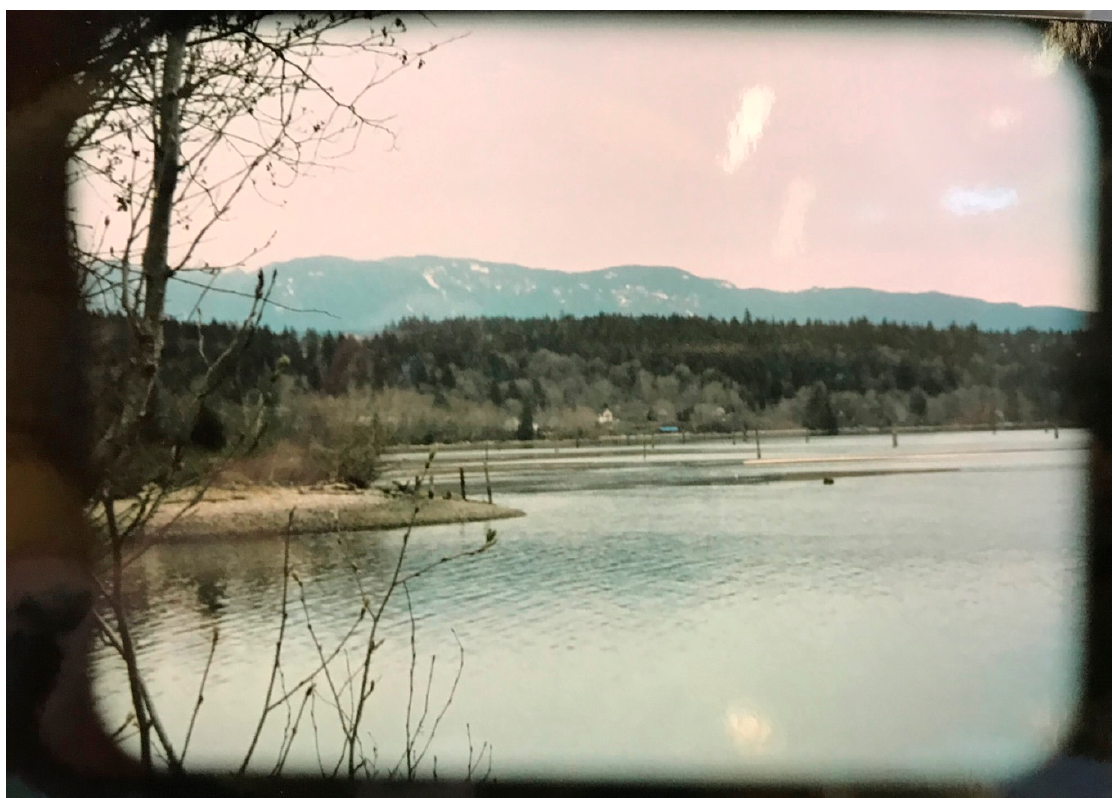
Figure 3. (Photo Credit: Lorelai Thomas).